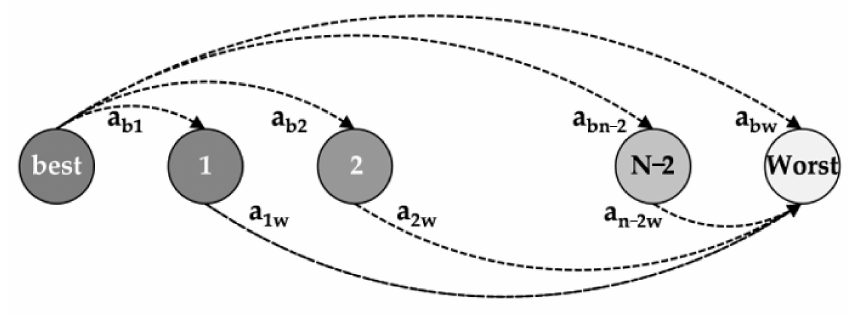
Figure 11. Importance comparison between